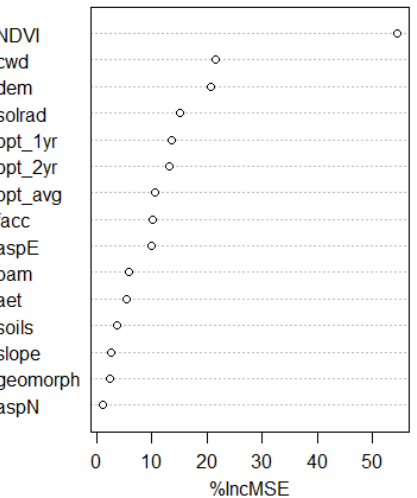
Figure 2. Variable importance graph produced by the random forest (RF) model. See Table 1 for descriptions of the predictor variables along the y -axis. The x -axis units are the percent increase in mean standard error (MSE) if the variable was excluded from the model.